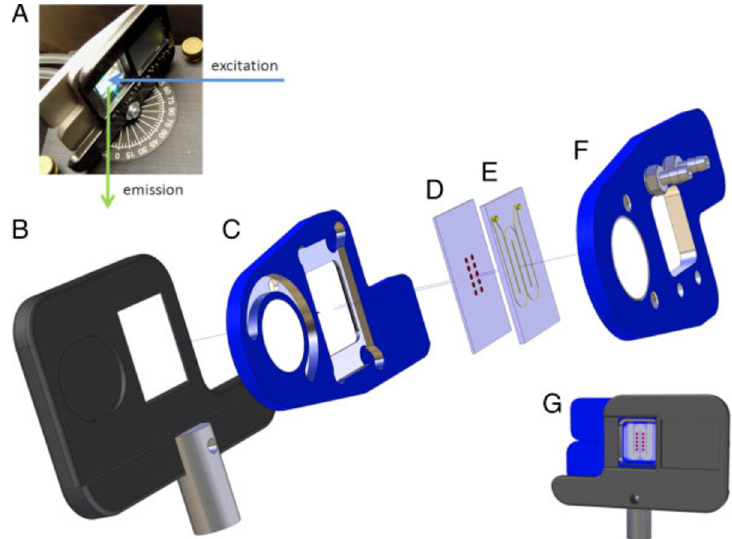
Figure 6. The microfluidic system and holder for fluorescence measurements (excitation and emission light beams in a spectrofluorometer ( A ); holder for the microfluidic system ( B ); magnetically connected holder with window ( C ) and ( F ); substrate on MIPs ( D ); microstructured meander for fluid transport ( E ); arranged setup with all components ( G )). Republished with permission from Thaler et al. [52].